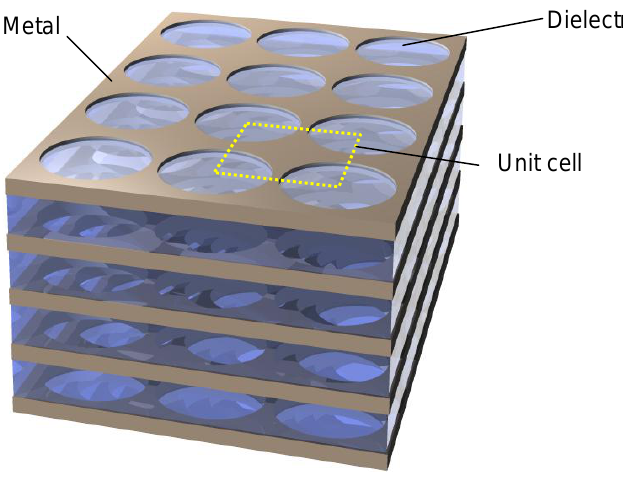
Figure 9. A multilayer stack of fishnet type, circular apertures filled with dielectric arranged in square lattice.